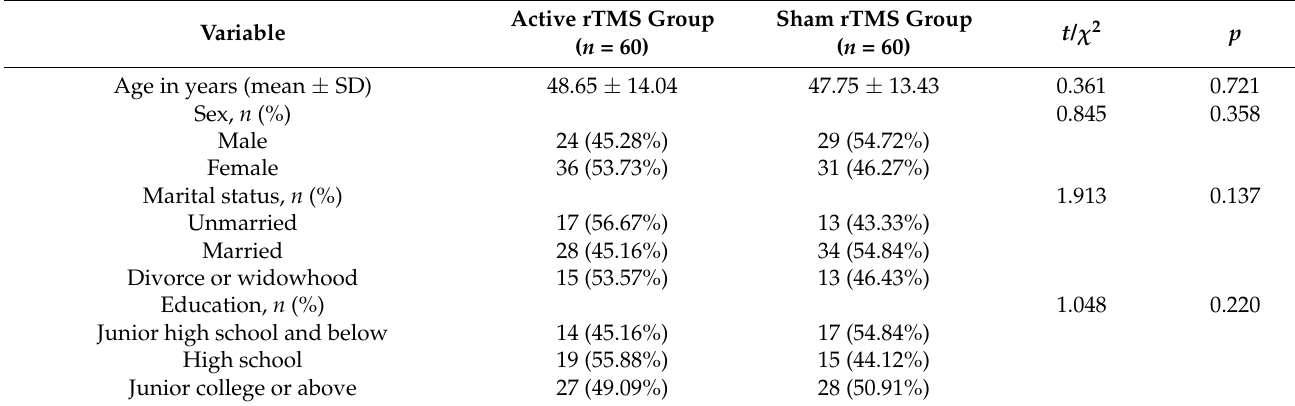
Table 1. Baseline sociodemographic characteristics of the sample population.